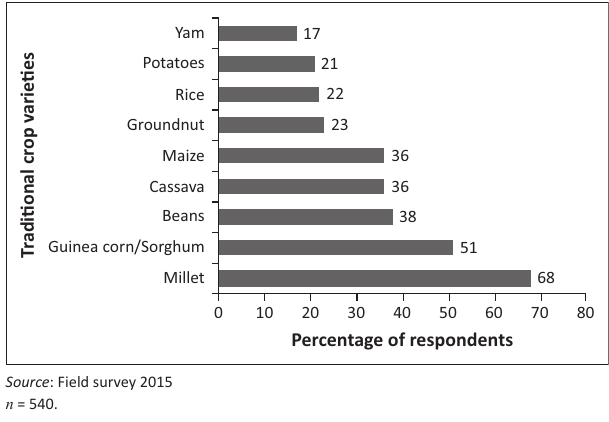
FIGURE 4: Indigenous crops some farmers have stopped